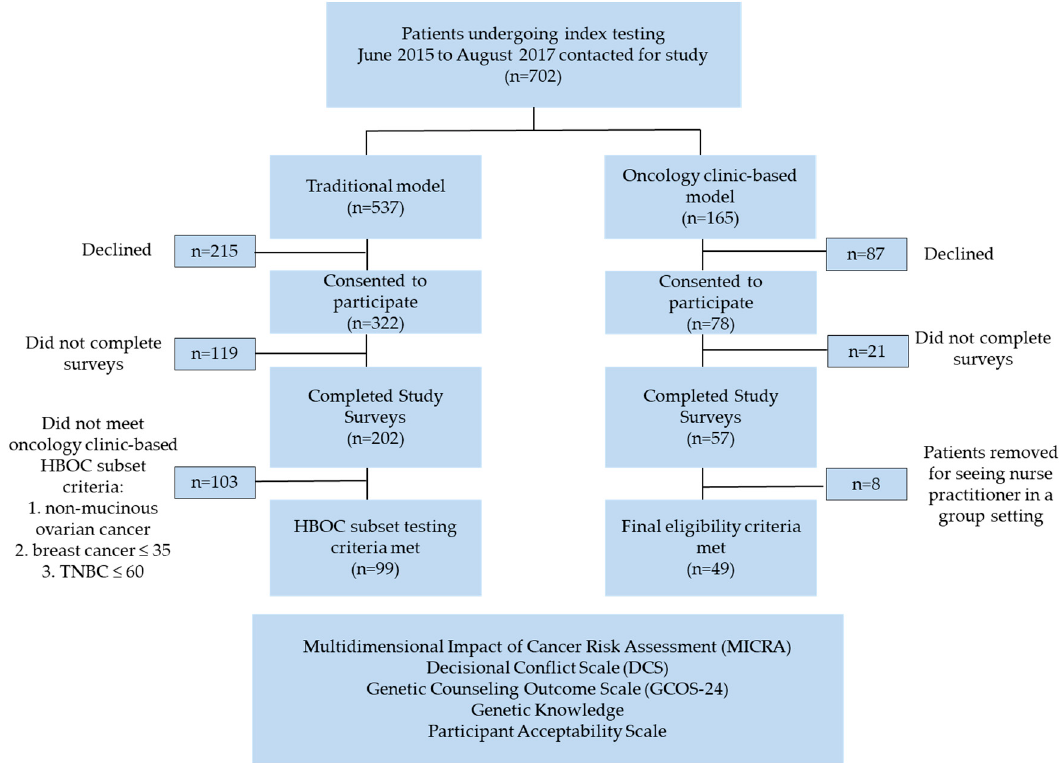
Figure 1. Study Design: The study inclusion criteria with a breakdown of the number of patients included and excluded.